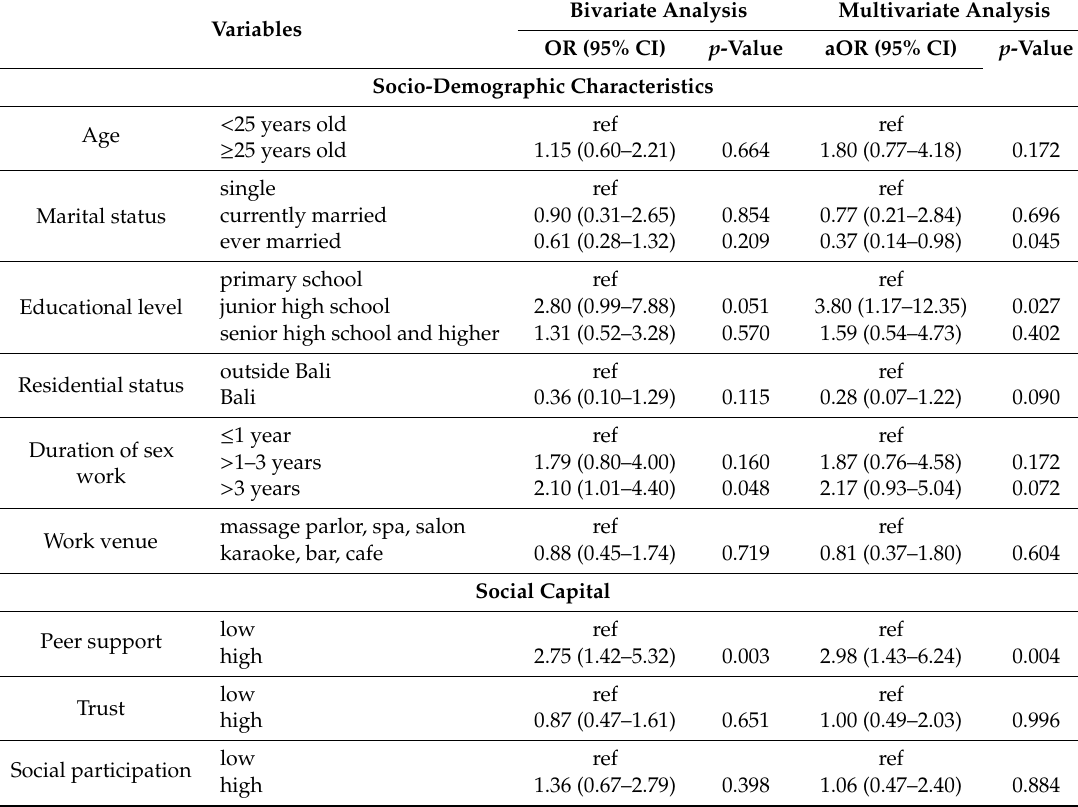
Table 3. Bivariate and multivariate analysis of social capital and HIV testing uptake.